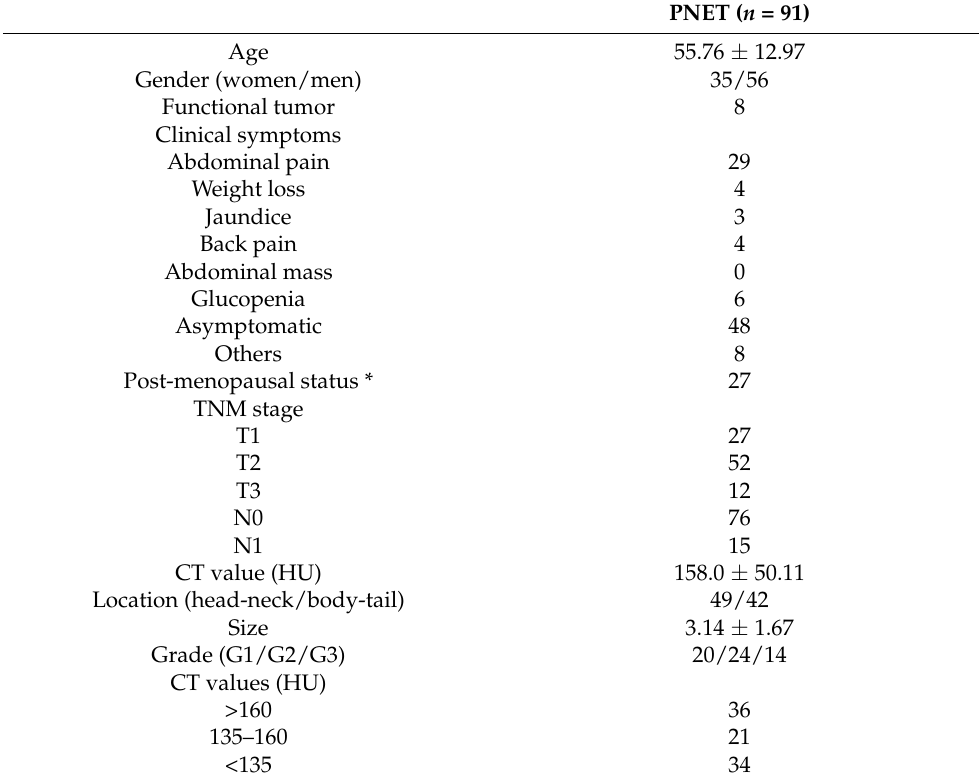
Table 1. Characteristics of